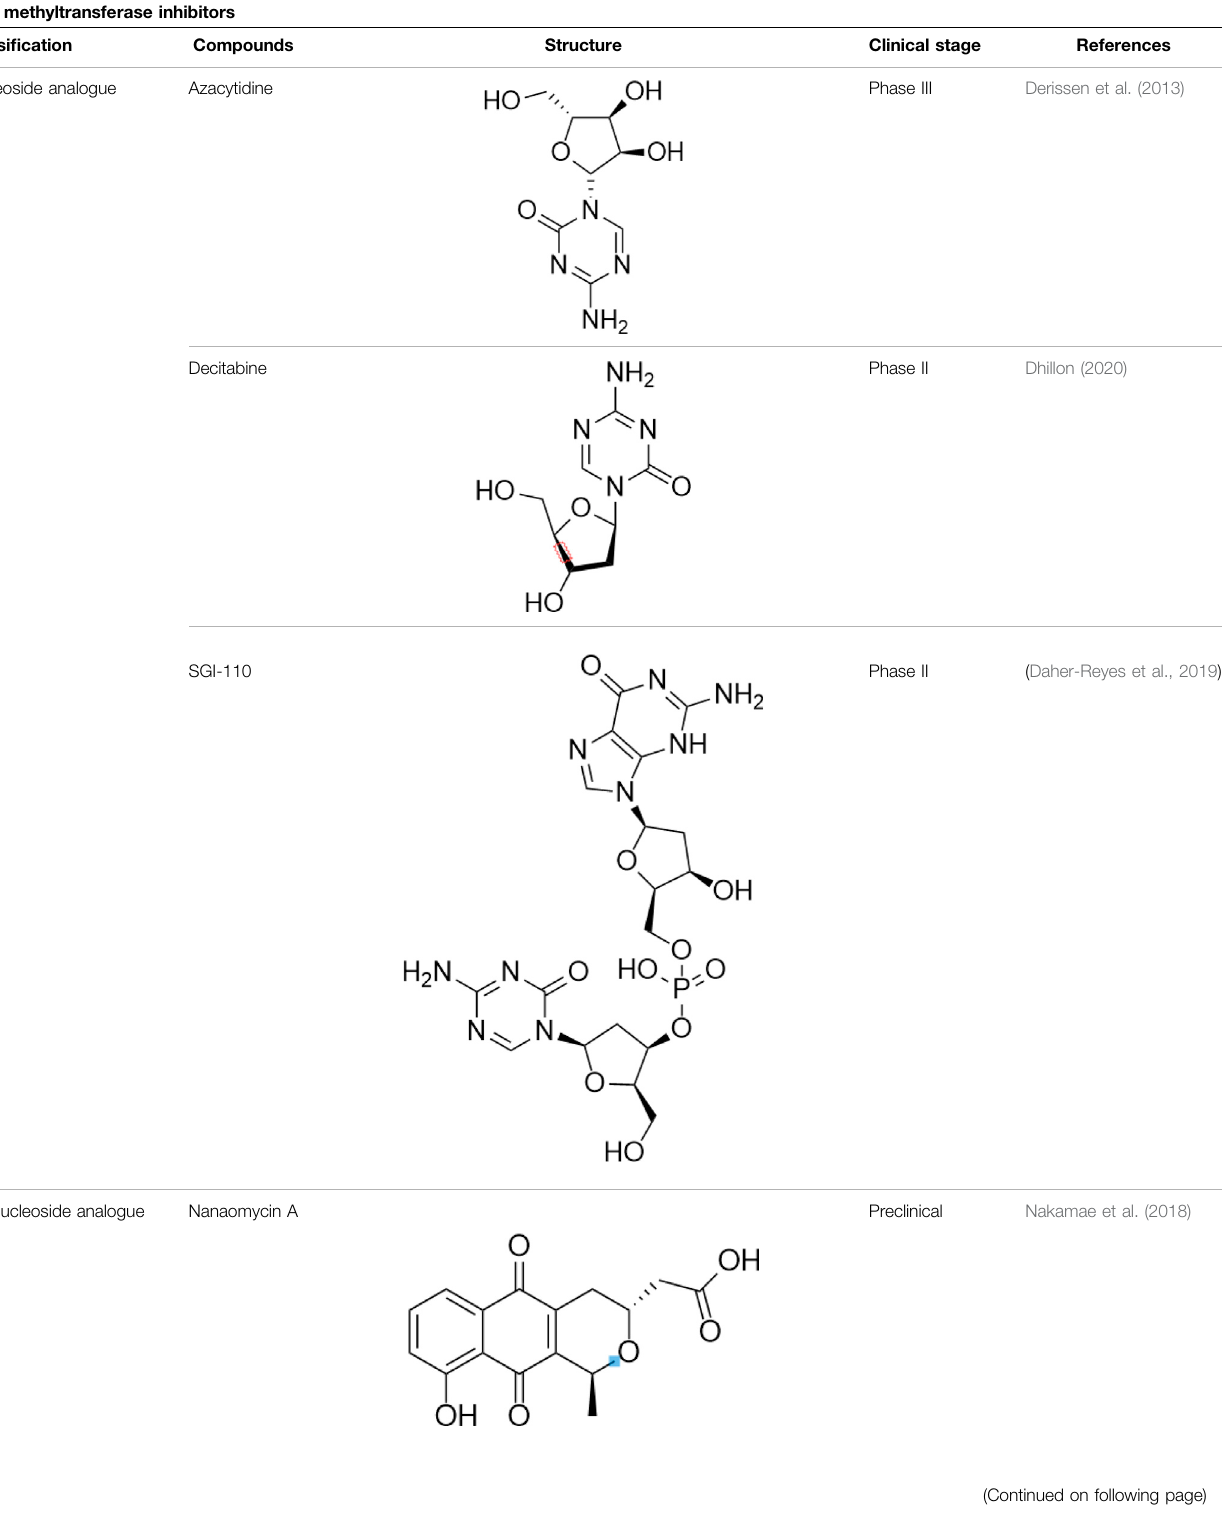
TABLE 1 | A list of DNA methyltransferase inhibitors under different phases of clinical trial and their indication. DNA methyltransferase